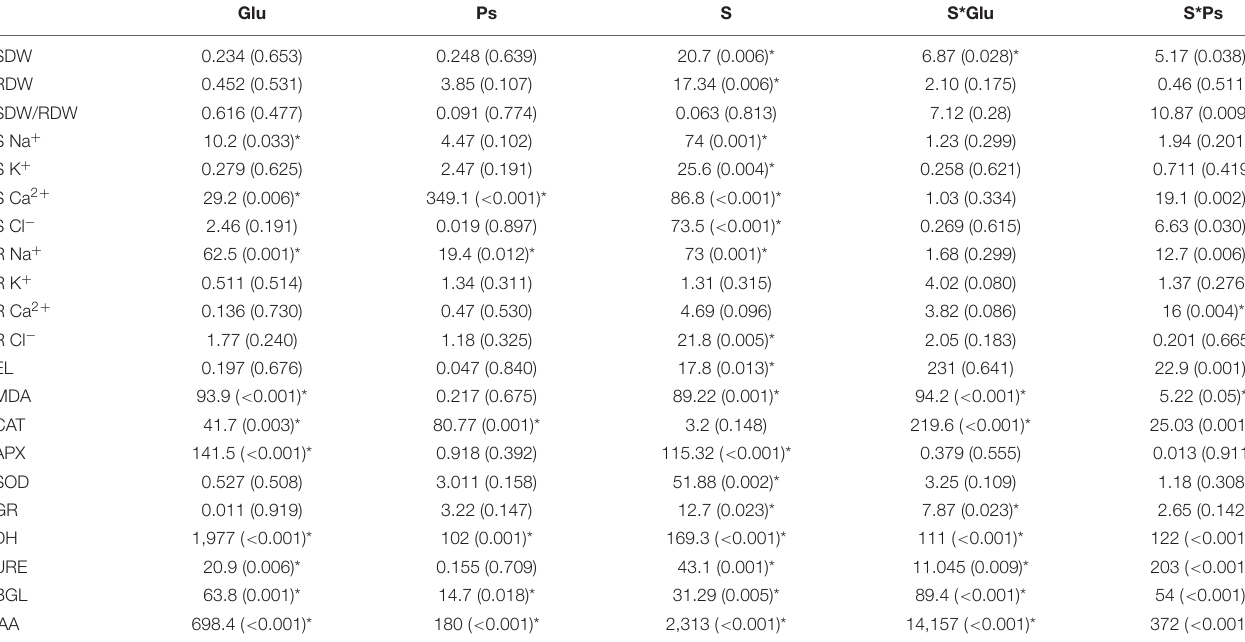
TABLE 1 | Two factors ANOVA (bacterial inoculation and saline stress) for all parameters studied of S. fruticosa [ F -values ( P -values)]. Glu